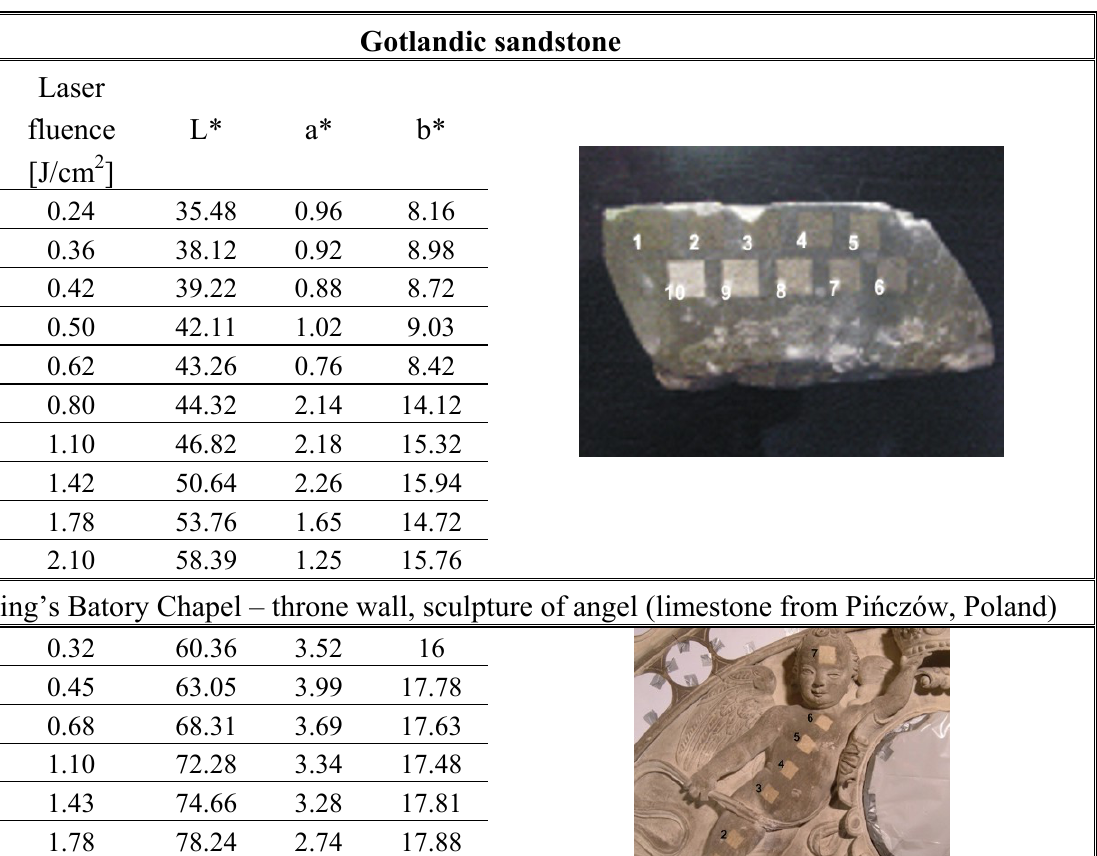
Table 3. Color measurements of different stone substrates during laser cleaning